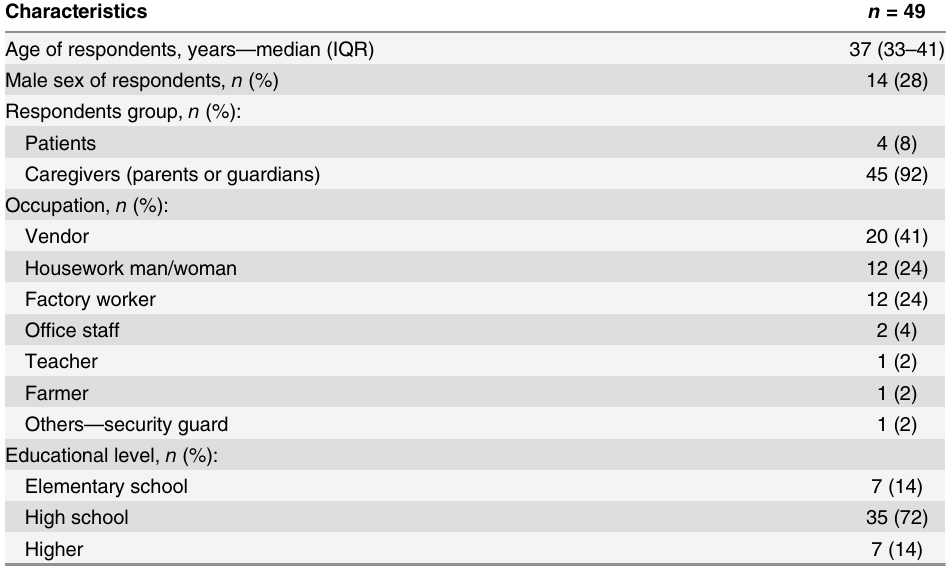
Table 2. Demographic characteristics of participants in the patient group who responded to the KAP survey.